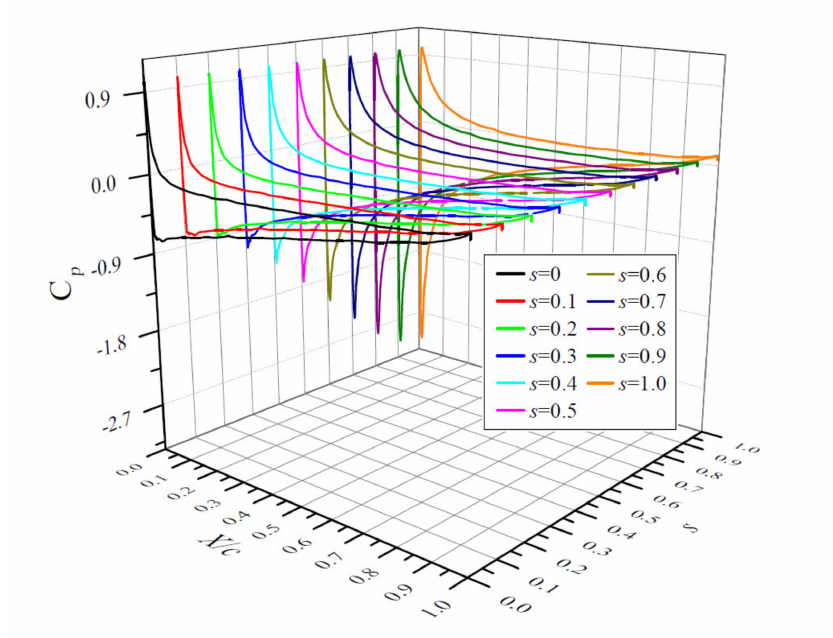
Figure 7. C p distribution at different spanwise s